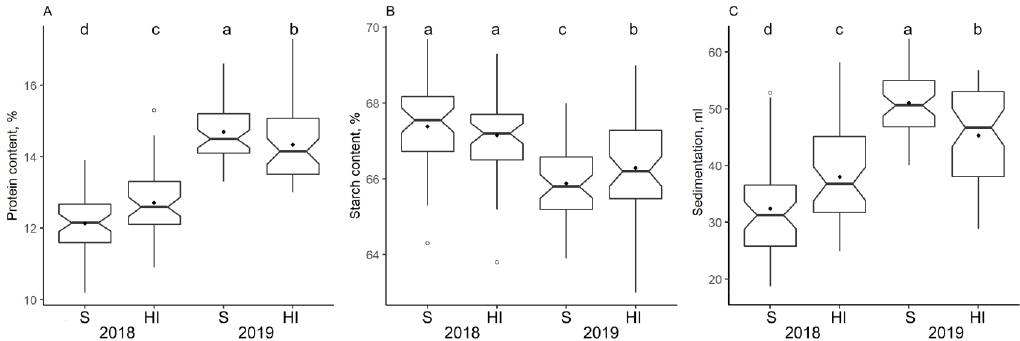
Figure 4. Winter wheat protein content (%) ( A ), starch content (%) ( B ) and sedimentation volume (ml) ( C ) of sustainable (S) and high-input (HI) trials in 2018–2019. Means followed by the same letters are not significantly different ( p < 0.05, Tukey HSD test, n =